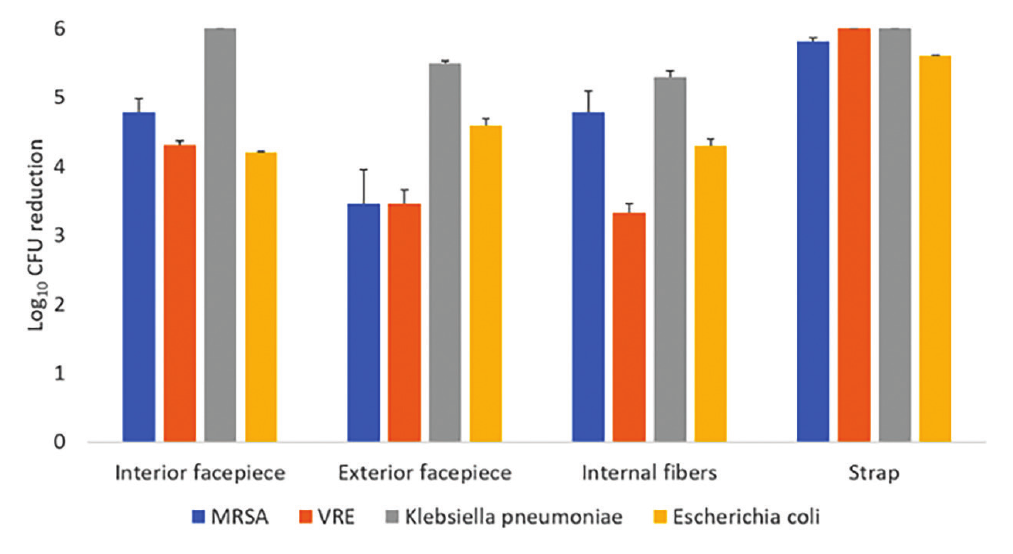
Figure 4. Log reductions in 4 vegetative bacteria on Moldex 1513 N95 respirators after exposure to 10 ultraviolet-C (UV-C) light inside the SUDS UV-C box. The test organisms were inoculated on the exterior facepiece, interior facepiece, internal fibers, and strap. Error bars indicate standard error.